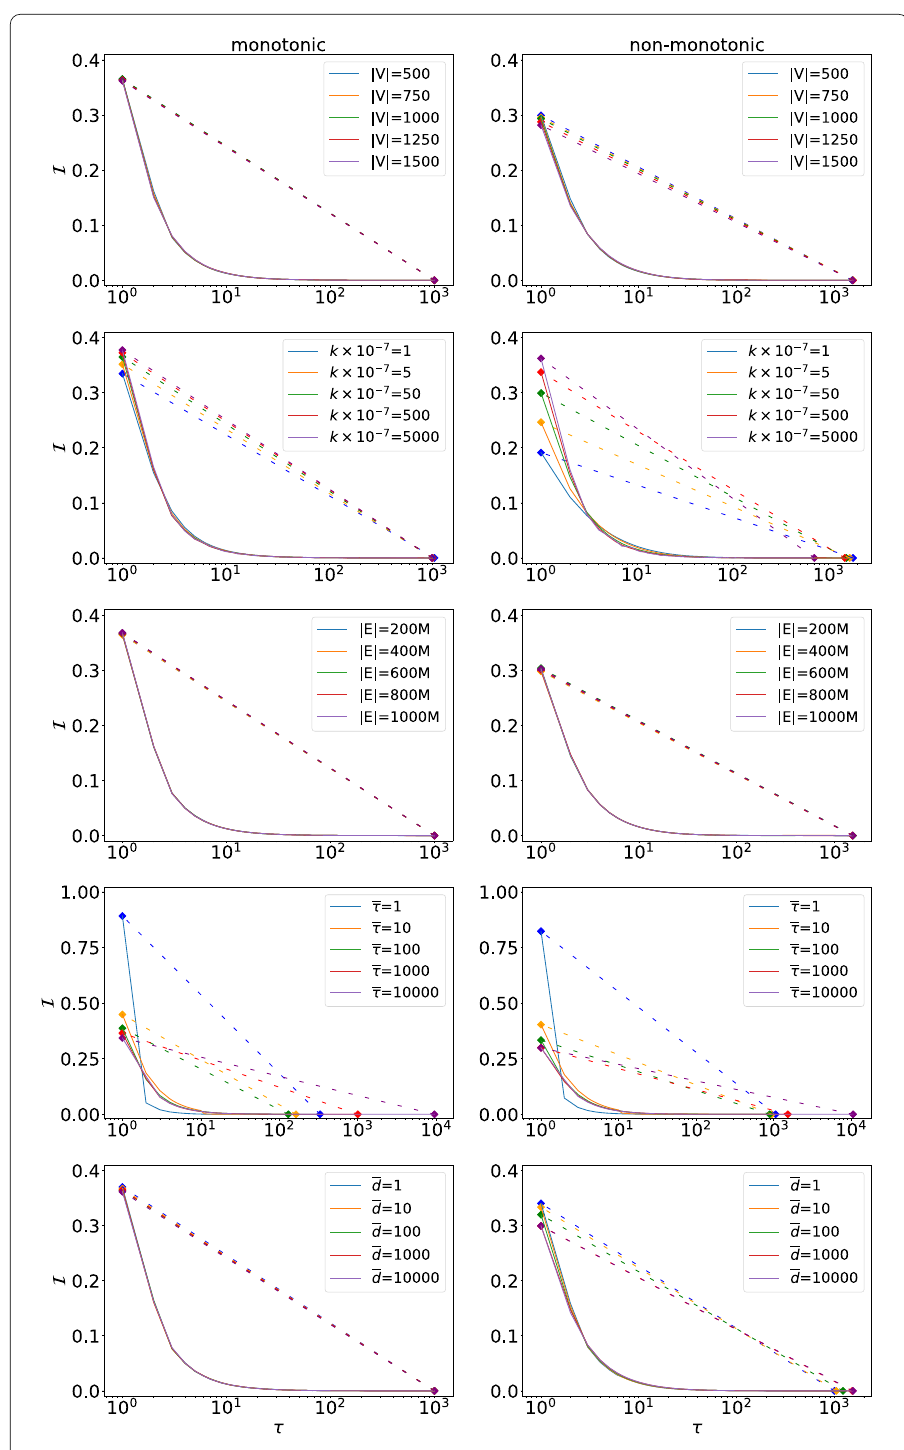
Figure 11 The IET distribution in various networks. We note that (1) higher k tends to enhance the IETs’ aggregation one small values; and, (2) higher τ , d tends to weaken the